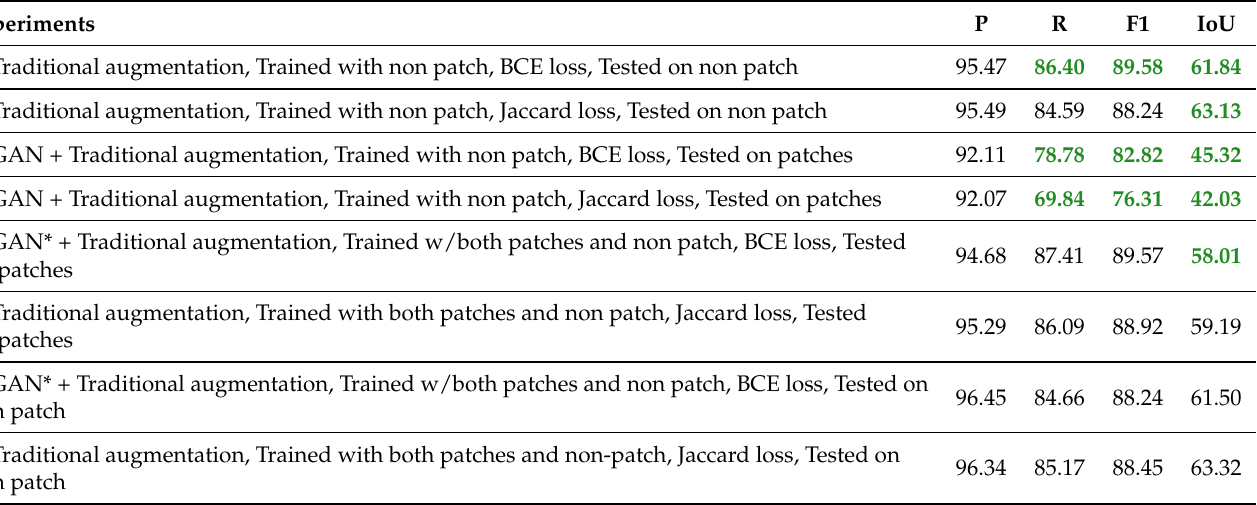
Table 10. Best UNet scenarios in eight experiments. The GAN augmentation scenario marked with an asterisk ( ∗ ) include the generated images of a GAN trained solely on the zoomed-in image patches as well as the generated images of a GAN trained exclusively on the resized